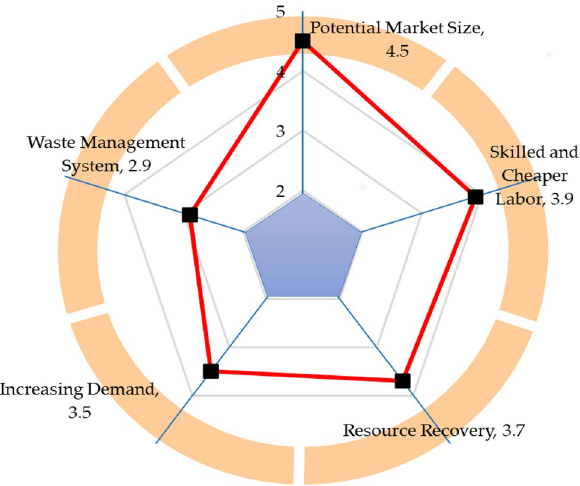
Figure 9. Strengths of India’s ELV recycling